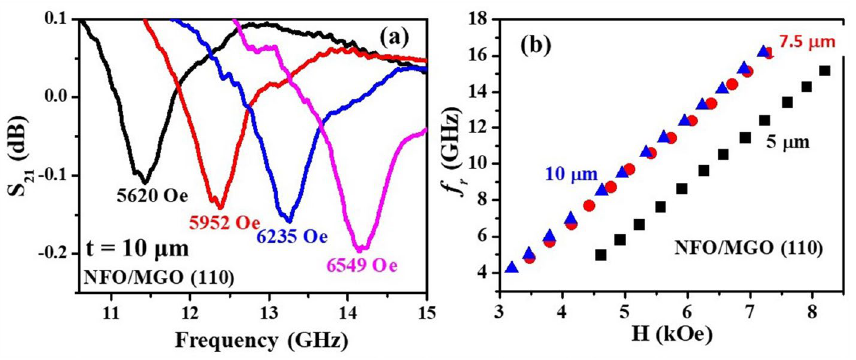
Figure 6. ( a ) Out of plane FMR data as in Fig. 5(b) for NFO film with thickness of 10 μm on (110) MGO and ( b ) f